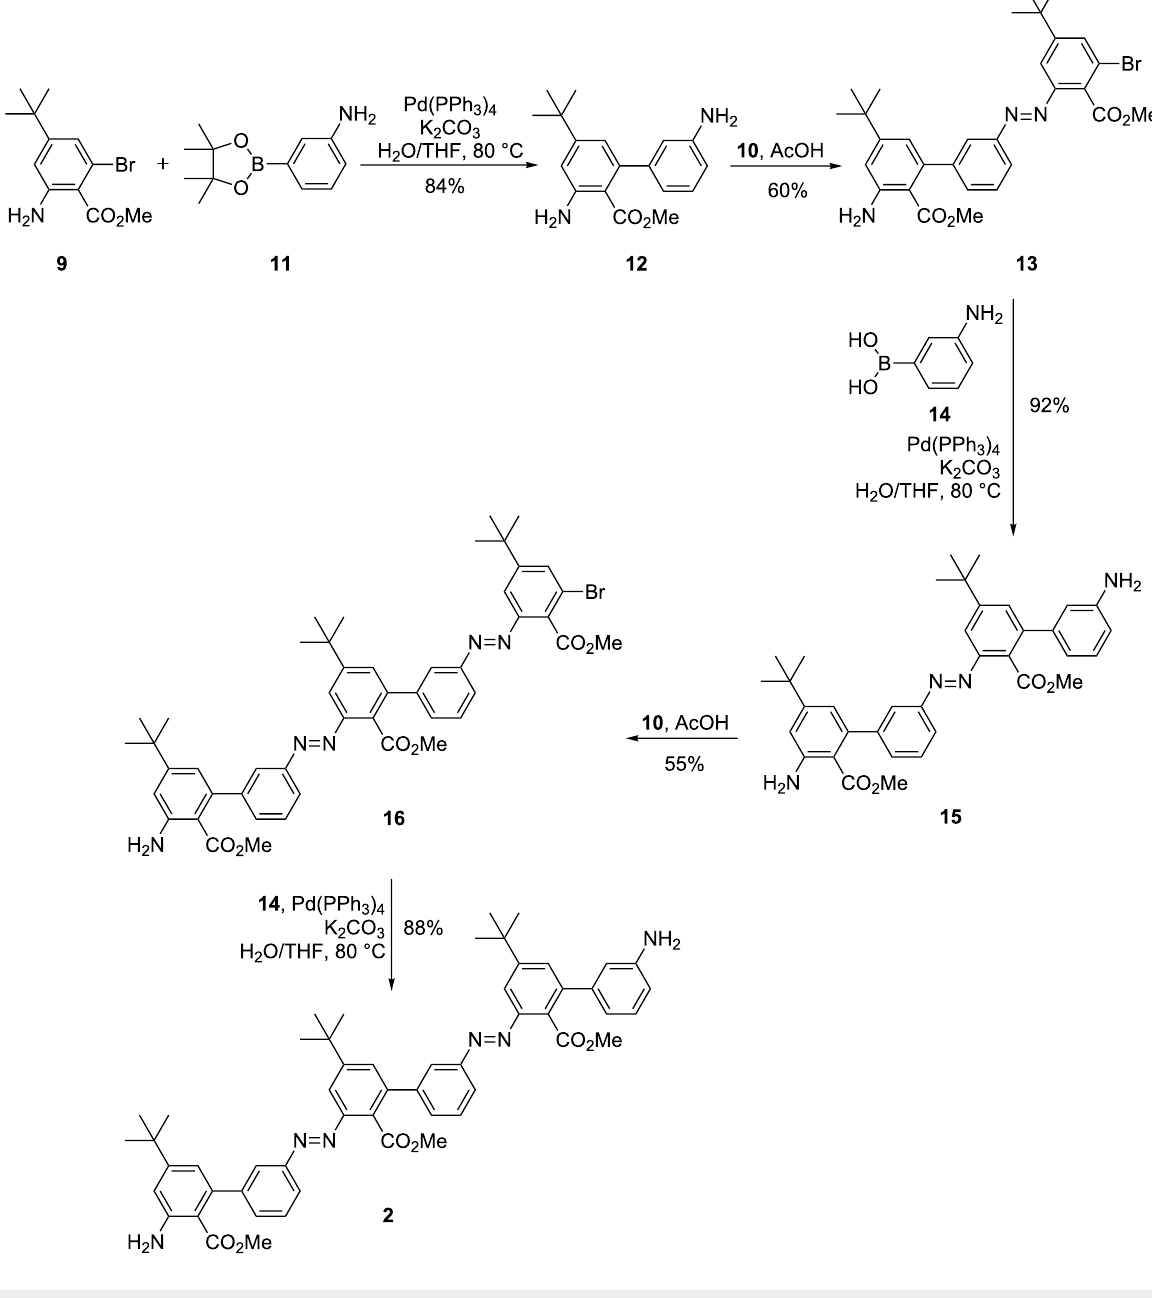
pinacolate, to eliminate the difficulties in the purification. The selective Mills reaction was again successful, giving only slightly lower